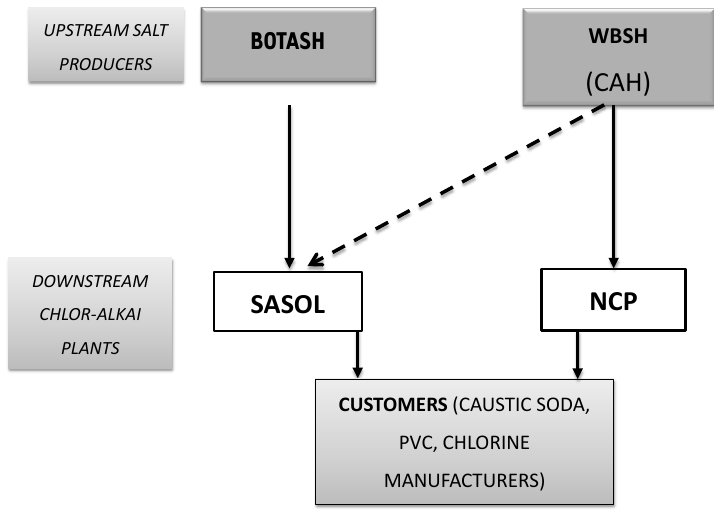
FIGURE 2: Value chain in the inland region Source: Authors’ own